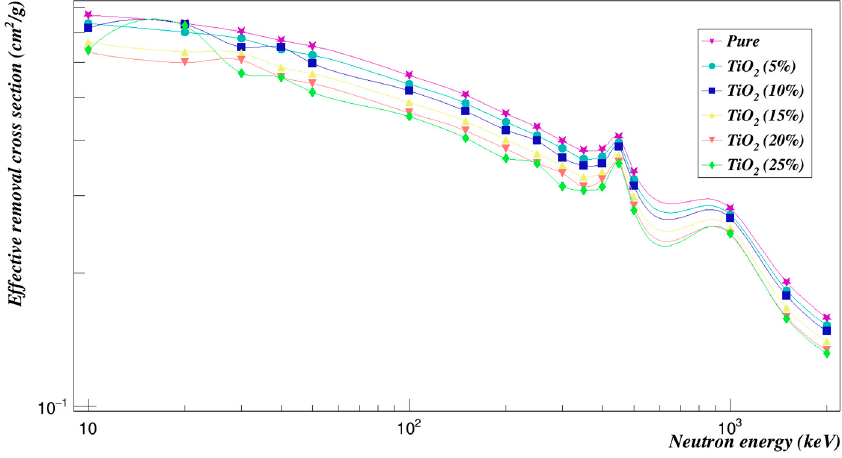
Figure 11. Neutron e ff ective removal cross sections of Polyimide doped with titanium dioxide.